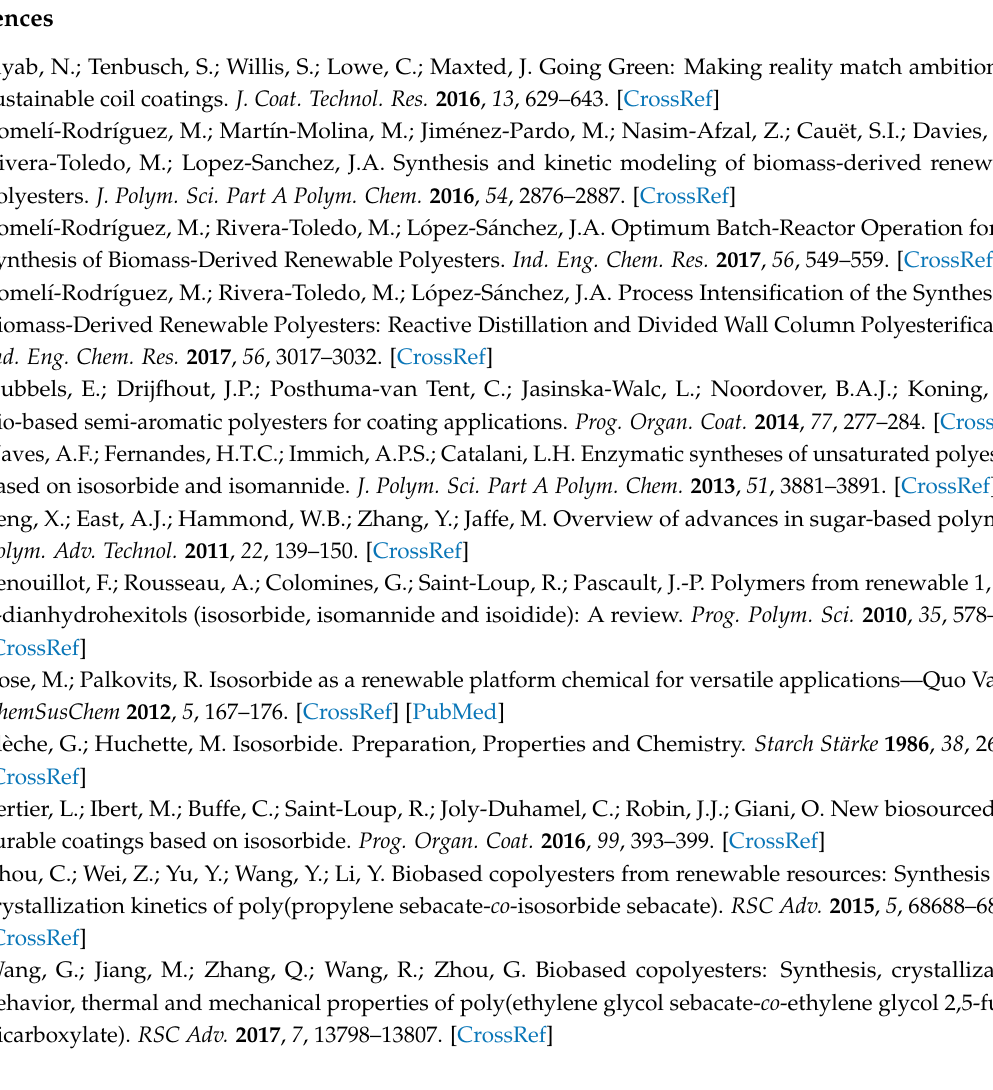
Figure S1: 1 H NMR of isosorbide monomer, Table S1: Monomer Charge for PPFIS Polyesters, Table S2: Monomer Charge for PPeFIS polyesters, Figure S2: 13 C NMR of PPeF 15 I 50 S 85 , Figure S3: HSQC of PPeF 15 I 50 S 85 , Figure S4: GPC chromatogram of polyesters PPeFIS with 30 mol % isosorbide, Figure S5: GPC chromatogram of polyesters PPeFIS with 50 mol % isosorbide, Figure S6: GPC chromatogram of polyesters PPF 15 IS 85 and PPF 30 IS 70 , Table S3: Thermal transitions of PPFIS measured by DSC, Figure S7: DSC thermogram of PPeF 15 IS 85 , Figure S8: DSC thermogram of PPF 30 IS 70 , Figure S9: First heating scan at 10 ◦ C/min for polyesters PPF 70 IS 30 , Figure S10: T g -M n -mol % isosorbide relationship for PPeF1 5 IS 85 , Figure S11: T g -M n -mol % isosorbide relationship for PPeF1 30 IS 70 , Table S4: Characteristic decomposition temperatures T d1 , T dmax and weight loss% of PPeFIS, Table S5: Characteristic decomposition temperatures T d1 , T d2 and T dmax and weight loss% of PPFIS, Figure S12: TGA thermograms for PPeF 15 IS 85 and PPeF 30 IS 70